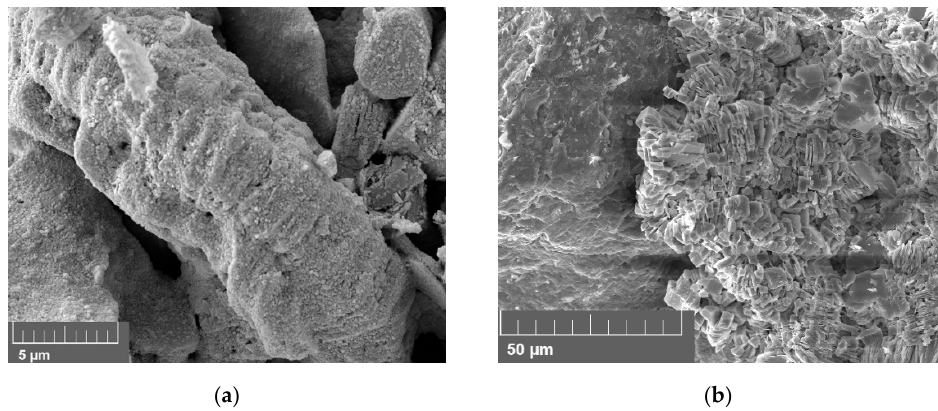
( a ) ( b ) Figure 18. Scanning electron microscope (SEM) images measured for the core material used in this work. Nanomaterials are adsorbed in patterns parallel to mineral edges. The images show vacuum saturation samples of 1wt% NF A in FW ( a ) and 1wt% NF B in TW ( b ).